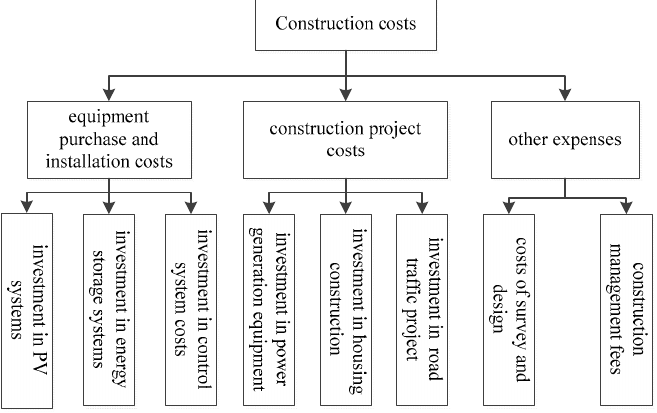
Figure 1. Construction costs of the photovoltaic-battery energy storage system (PV-BESS) power plants.